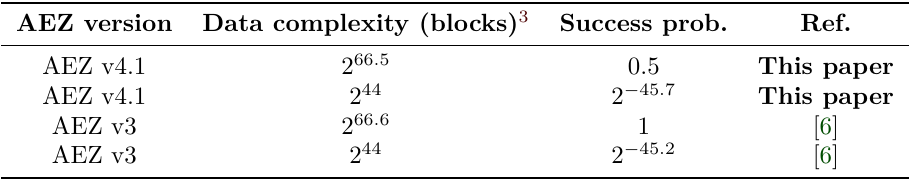
Table 1: AEZ attacks